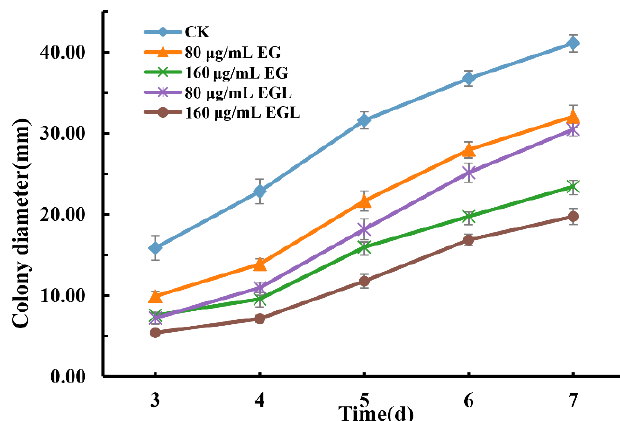
Figure 3. Colony diameters of P. italium after incubation for 3–7 d after different treatments.